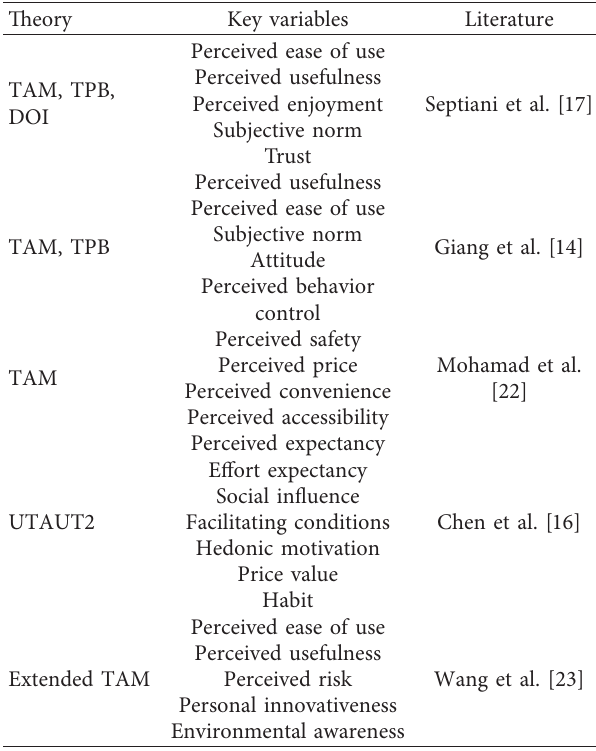
Table 1: Summary of